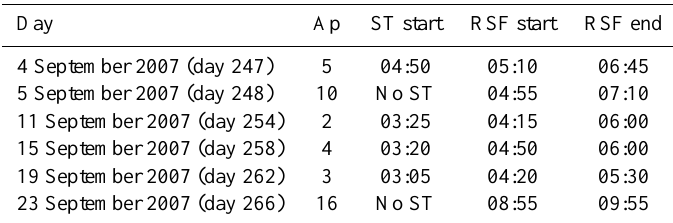
Table 1. UT start and end of RSF at Tucum´an on September